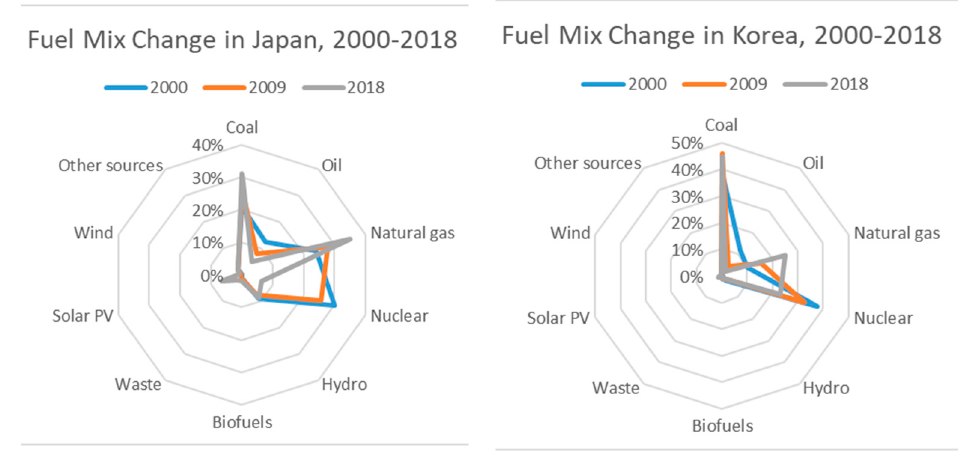
Figure A1. Fuel Mix Change in Japan and S. Korea, 2000–2018.